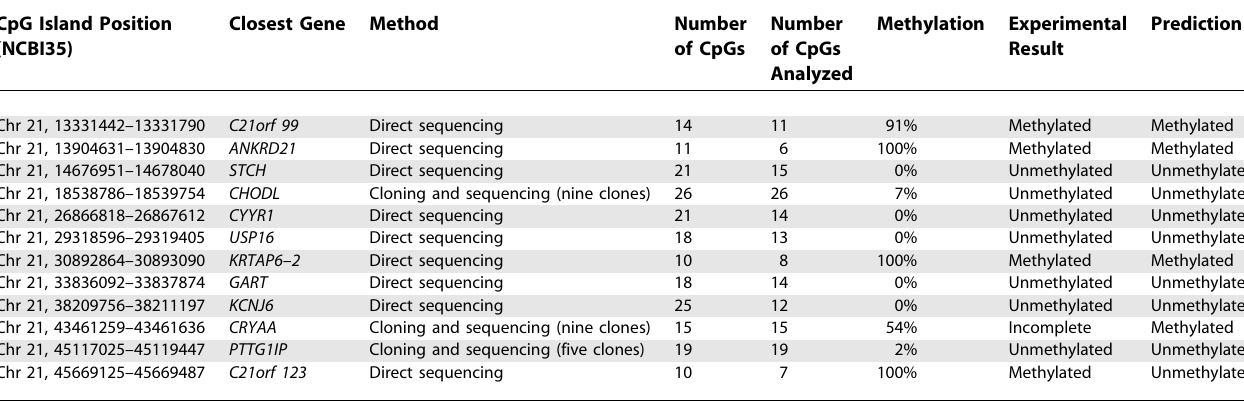
Table 3. Twelve CpG Islands Were Analyzed Experimentally to Validate Our Predictions CpG Island Position